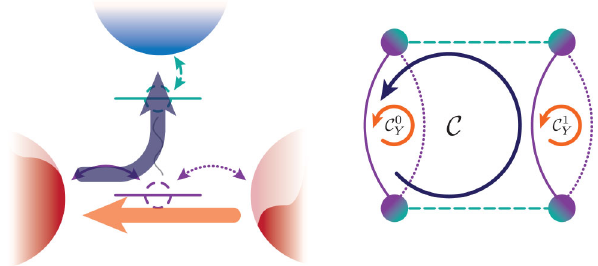
FIG. 3. Illustration of cycles in a bipartite graph: The global cycle C (blue arrows) has links in both systems (dashed teal horizontal lines and solid purple vertical lines), and its current supports an energy flow between the two subsystems. Local cycles of Y , C 0 Y and C 1 Y (orange arrows), describe particle flow between the two particle reservoirs of the lower